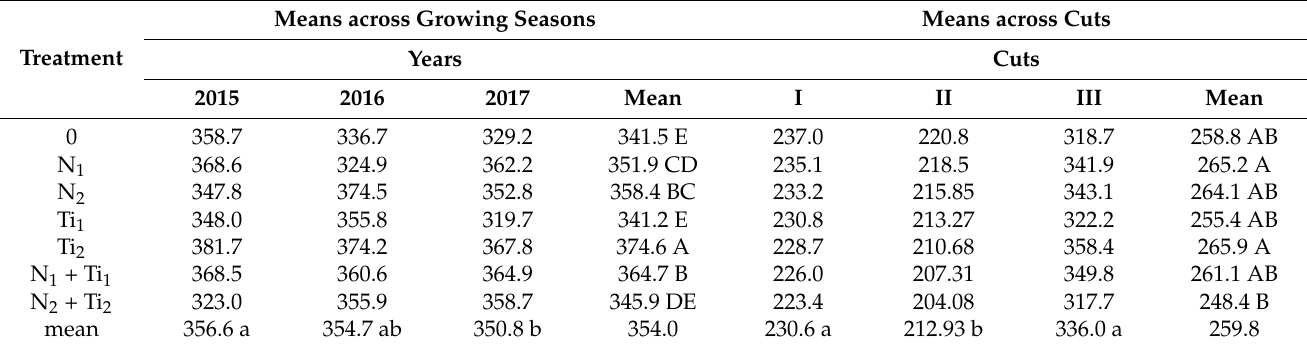
Table 5. Acid detergent fibre (ADF) content in Festulolium braunii (g kg − 1 DM). Means across Growing Treatment